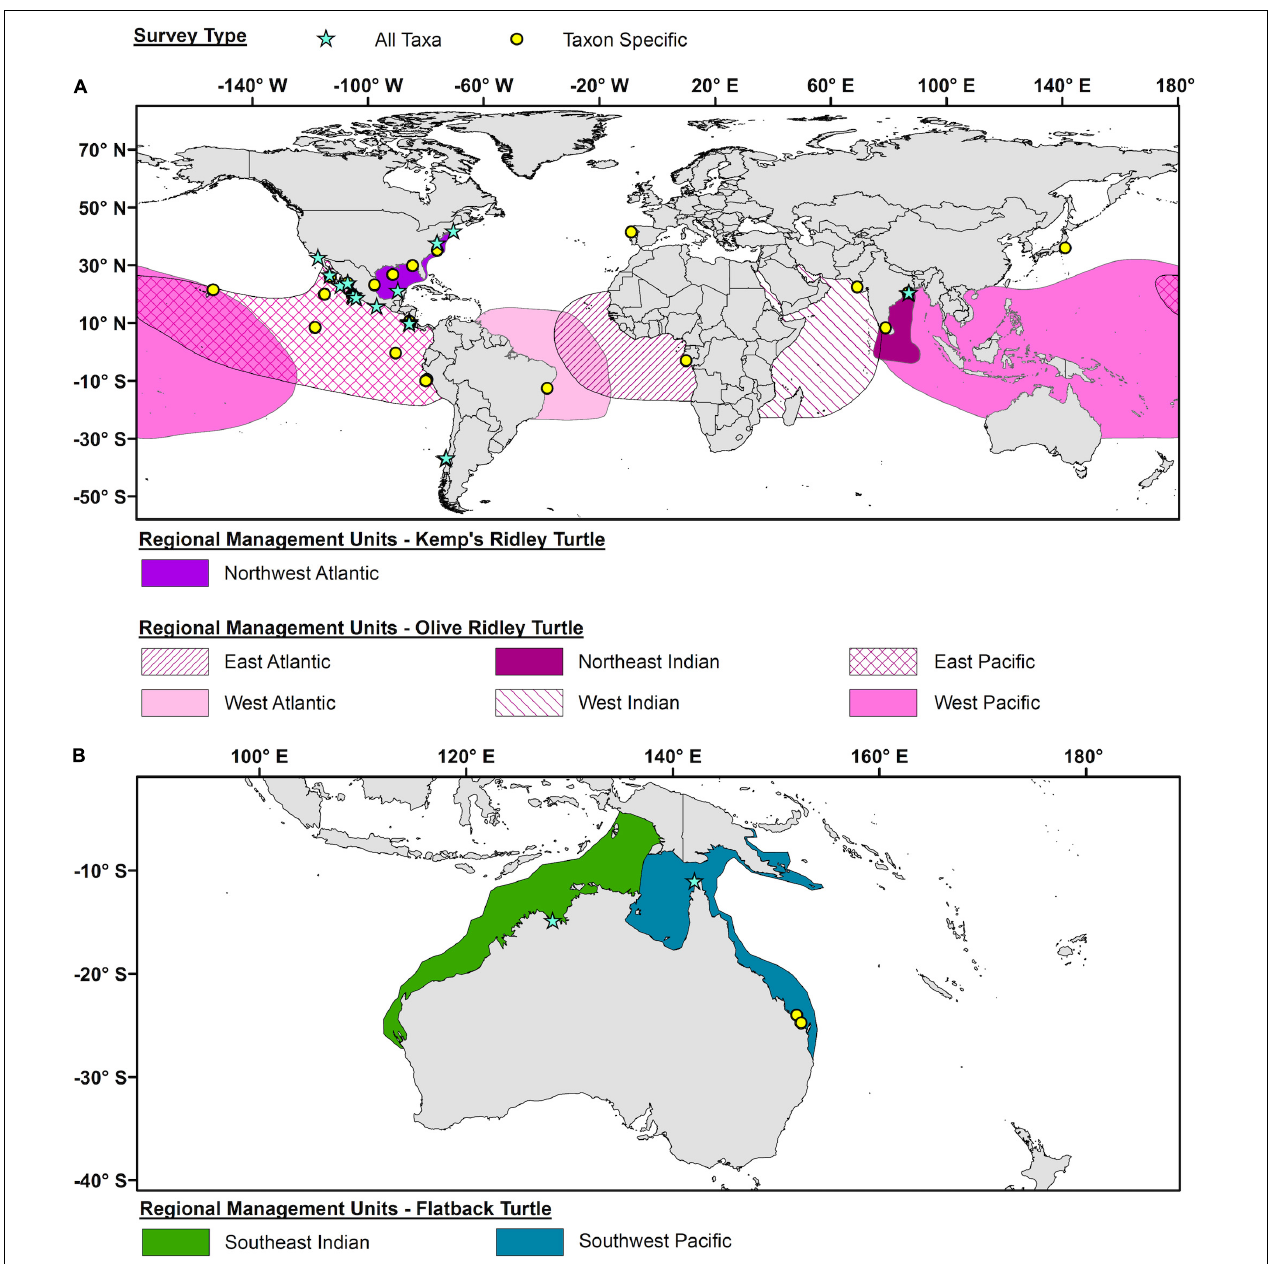
FIGURE 8 | Geographic distribution of all epibiont studies for (A) Kemp’s and olive ridley turtles ( Lepidochelys kempii and L. olivacea ) and (B) flatback turtles ( Natator depressus ). Blue stars represent studies that report on all potential taxa (All Taxa), while yellow circles represent studies that only focus on specific taxa (Taxa Specific. The geographic outlines for each Regional Management Unit as represented by differentially colored polygons (based on Wallace et al.,